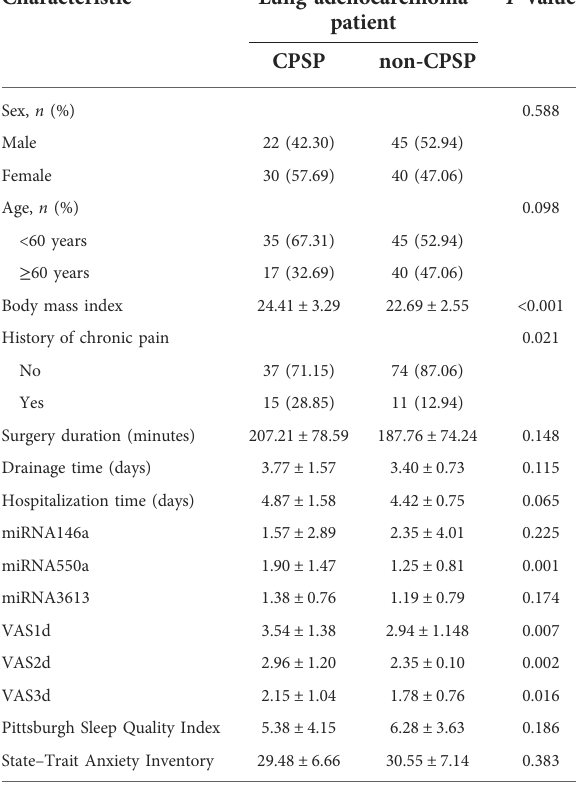
TABLE 1 Demographic and clinical characteristics of study participants.